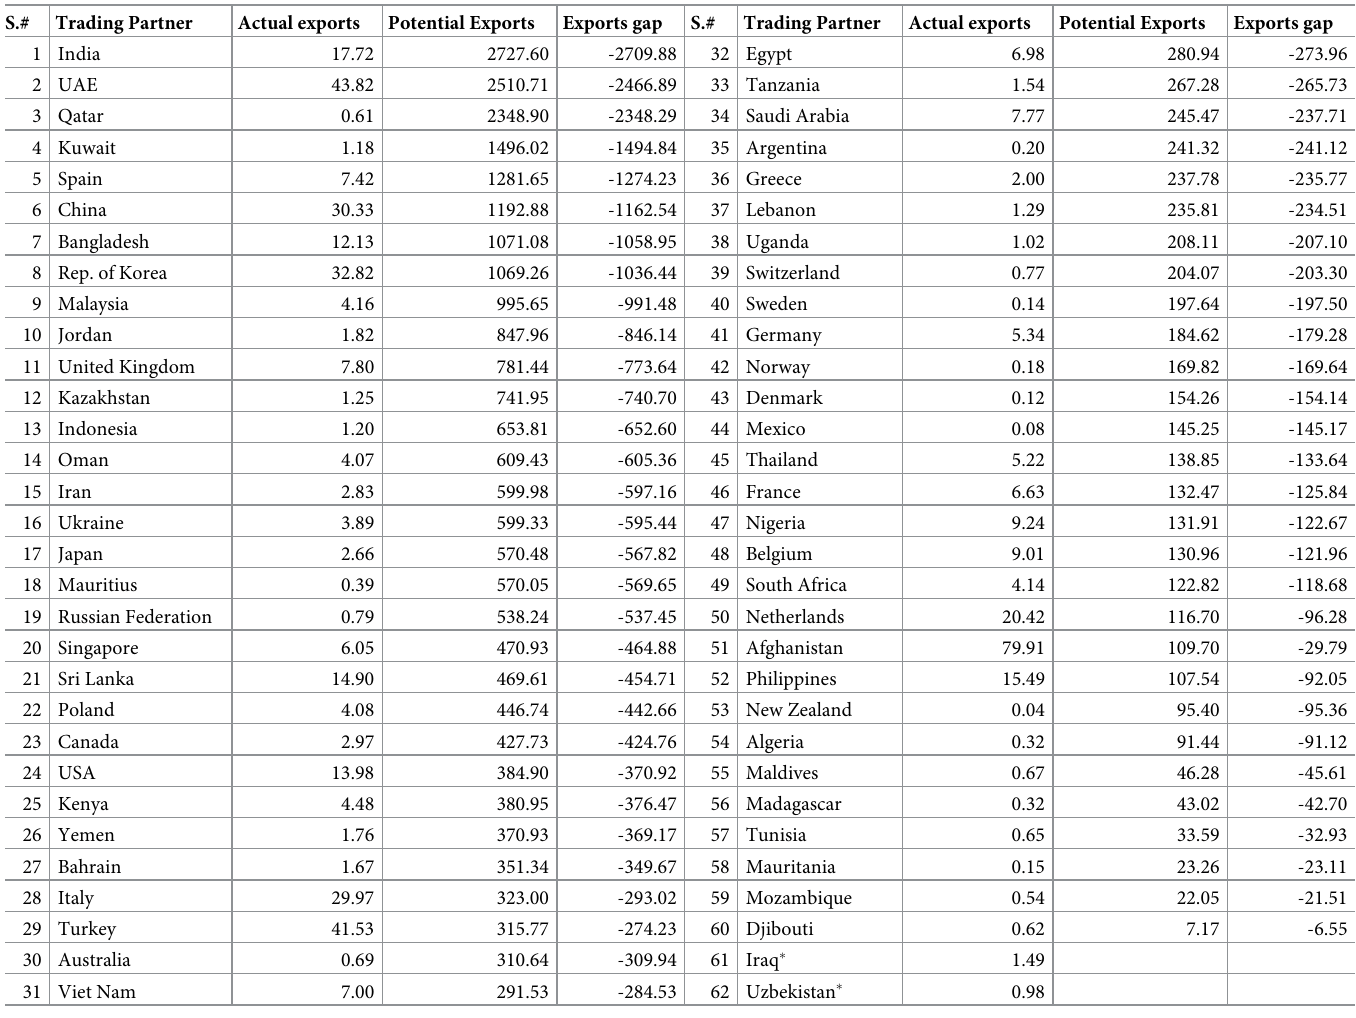
Table 6. Pakistan’s chemical products exports’ gap.